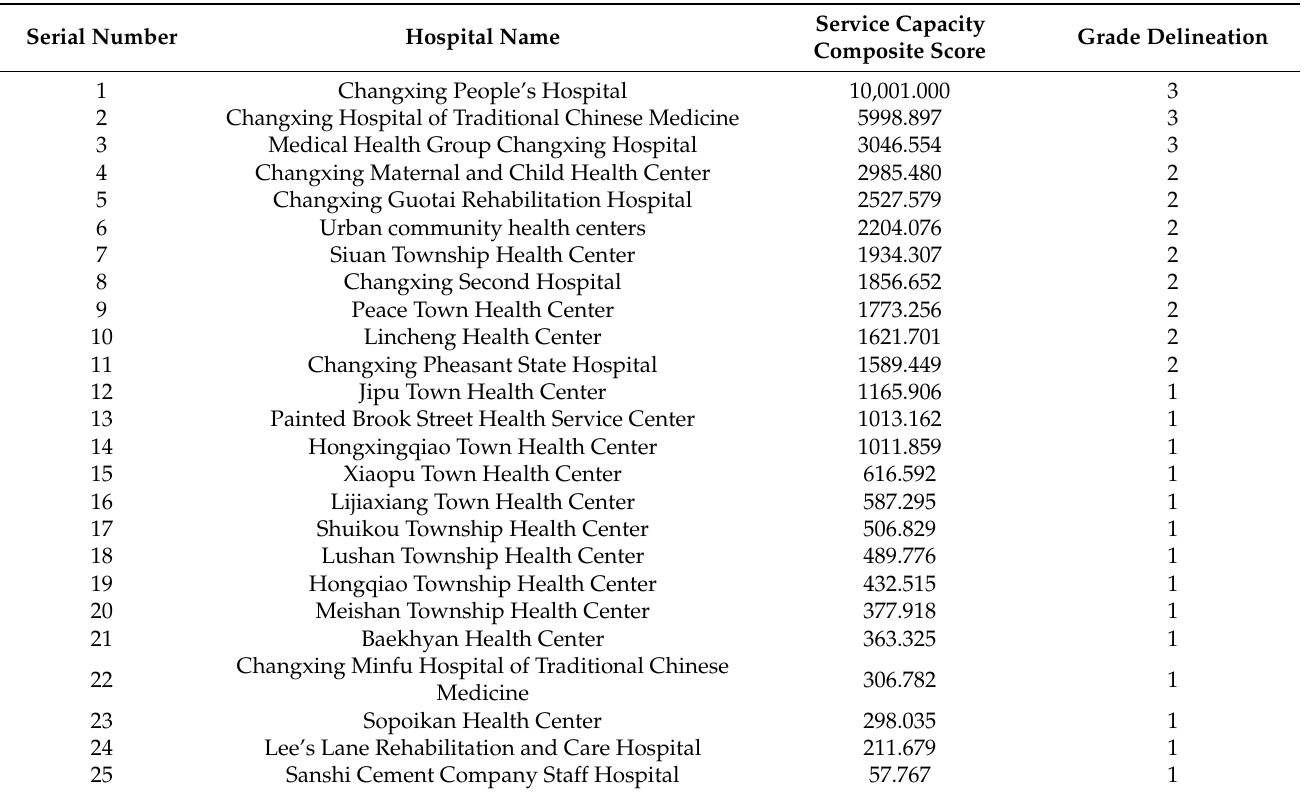
Table 5. Evaluating results of the level of Changxing medical